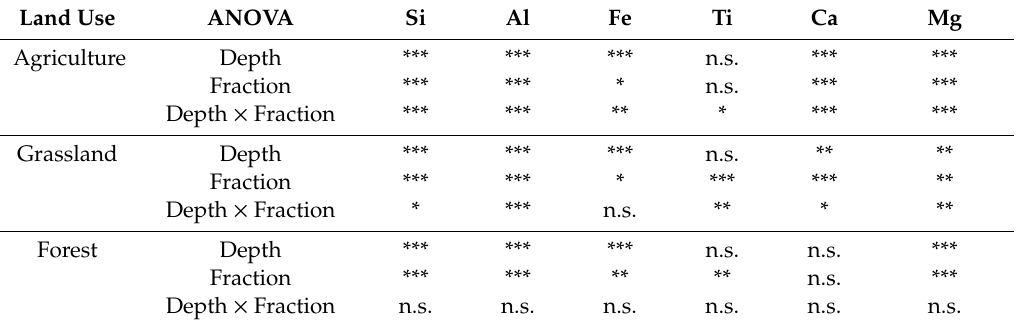
Table 4. Analysis of variance for the depth and fraction ( p -value) of each surface-coated element (EDS data) from three sandy soils under di ff erent land